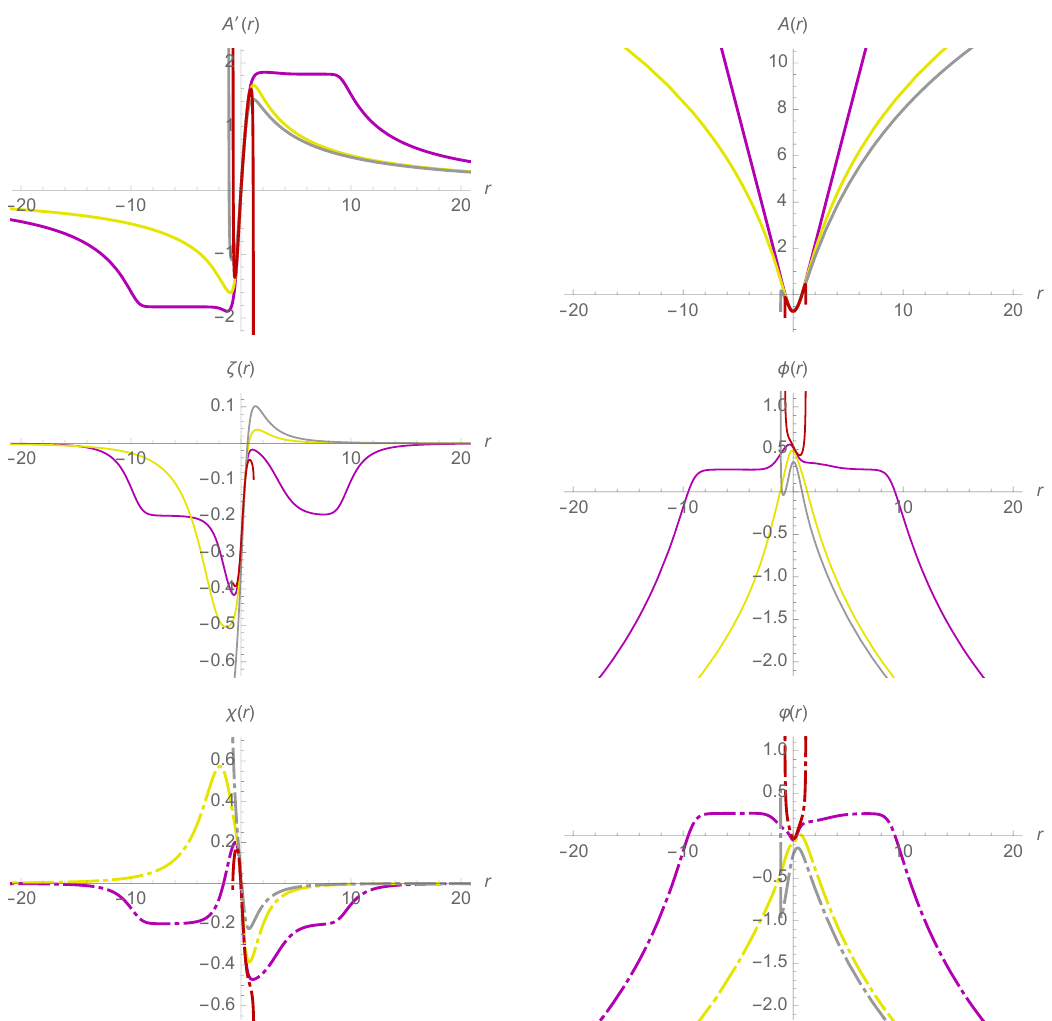
Figure 17. U(3) / SU(3) (purple), G 2 / U(3) (yellow), SYM/singularity (grey) and singular (red) N = 1 Janus solutions with SU(3)